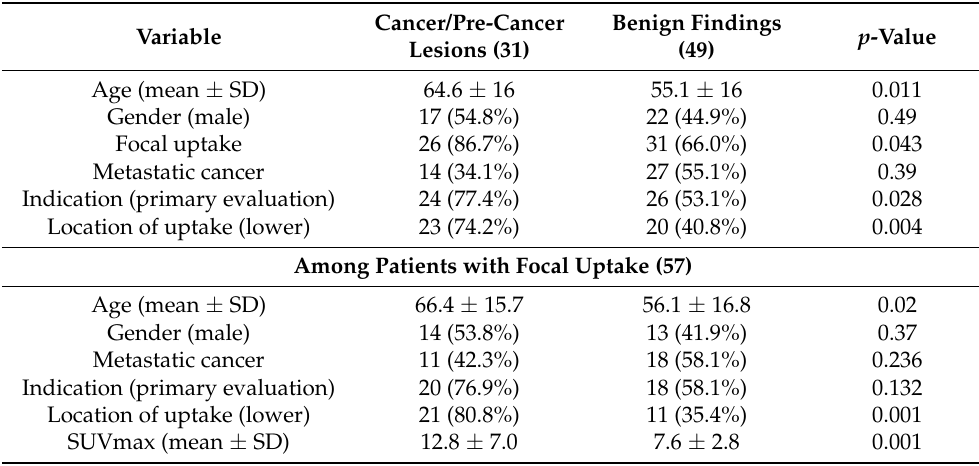
Figure 3. Case of a 71-year-old male known to have primary bladder cancer. Axial cuts of CT ( a ) fused with PET ( b ) showing a focus of increased uptake in the lower rectum (SUVmax 19.1) with corresponding circumferential wall thickening suspicious for malignancy. This lesion is redemonstrated in the MIP ( c ), sagittal ( d ), and coronal PET/CT cuts ( e ). Rectal biopsy confirmed the diagnosis of moderately differentiated adenocarcinoma. Table 6. Bivariate analysis comparing the clinical characteristics of patients with benign and malignant findings upon endoscopic